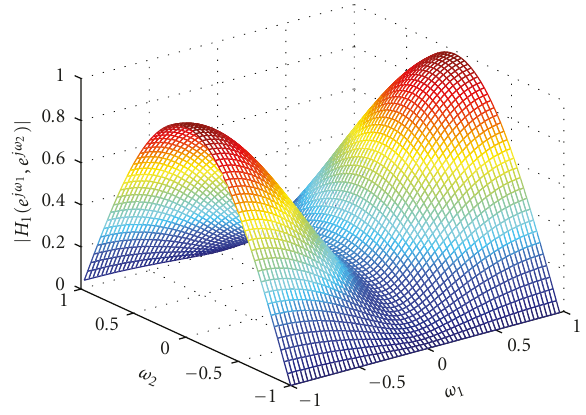
Figure 5: Normalized magnitude H 1 ( e jω 1 , e jω 2 ).